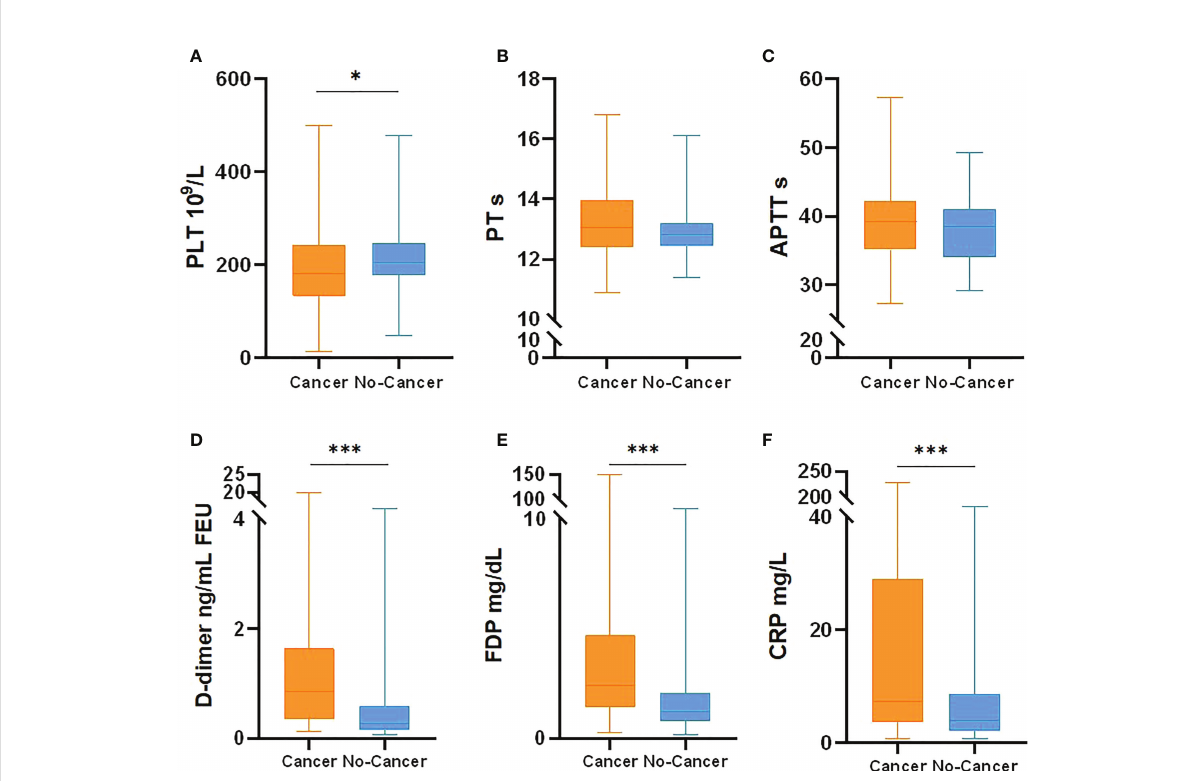
FIGURE 1 Coagulation related laboratory comparison between cancer patients with COVID-19 and no-cancer patients [ (A) PLT, (B) PT, (C) APTT, (D) D- dimer, (E) FDP, (F) CRP]. *p < 0.05, ***p < 0.001.